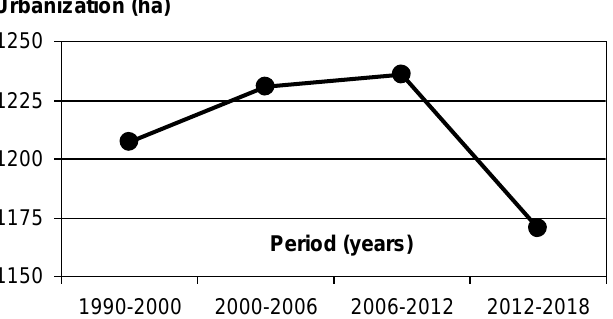
Figure 7. Dynamic of the urbanization of the Romanian seashore during 1990–2018. Figures reflect the urbanized area.